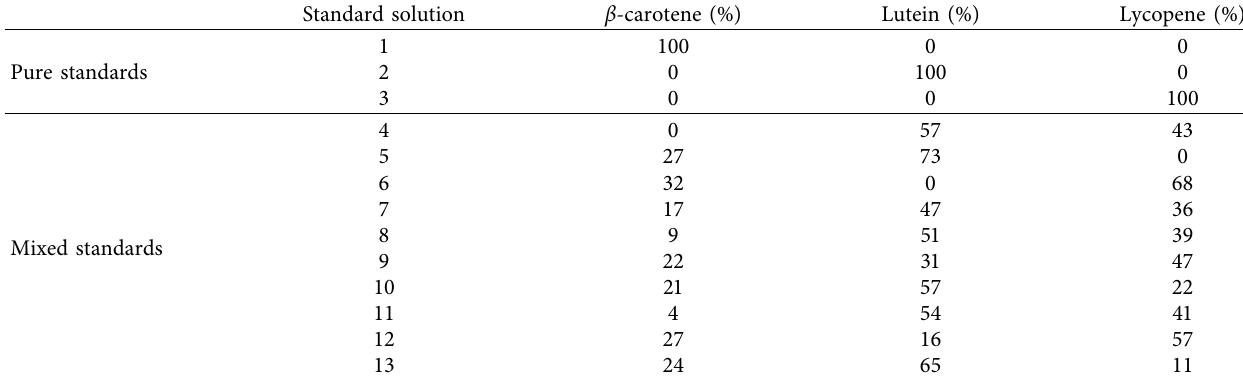
Table 2: Relative composition of carotenoids in standard solution